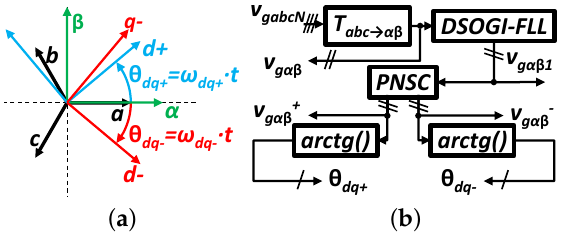
Figure 3. Detailing the synchronization system. ( a ) Static and synchronous reference frames; ( b ) Synchronization system